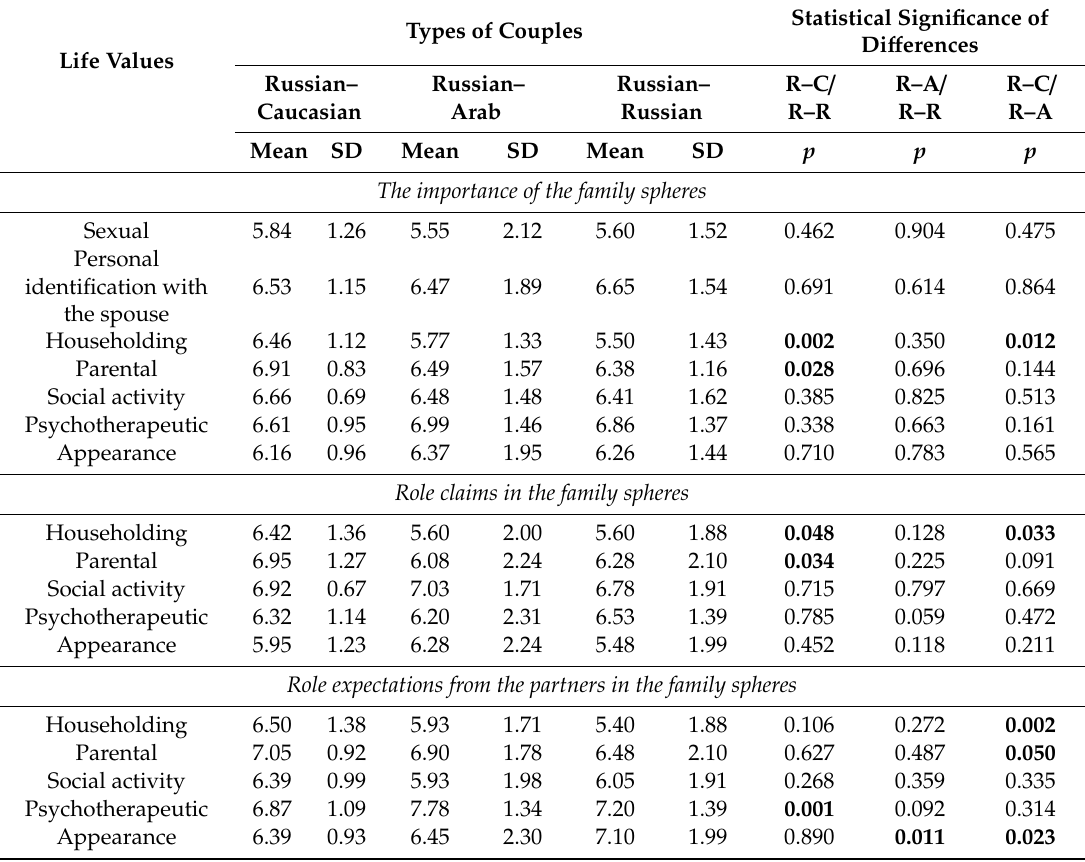
Table 2. Comparison of the importance of family values for spouses of mono-cultural, inter-ethnic and inter-faith